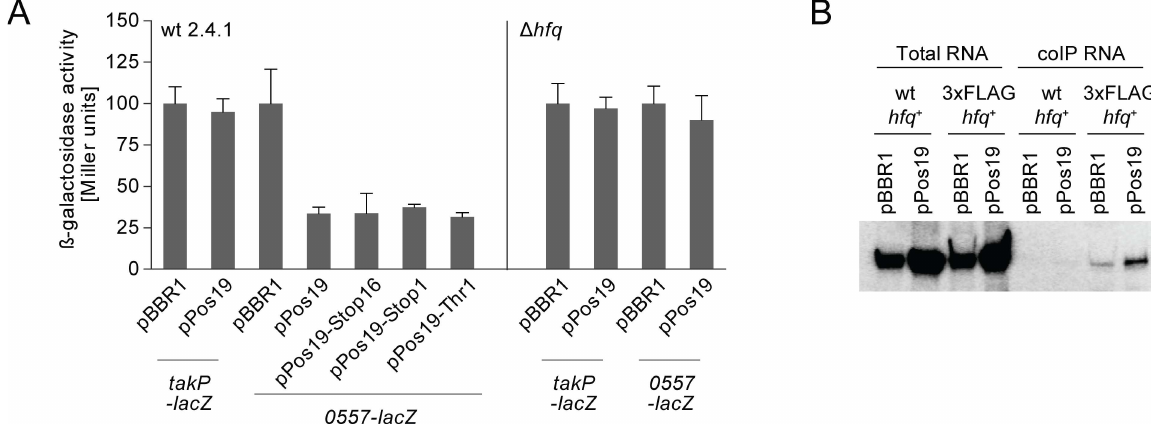
Fig 5. Regulation of RSP_0557 by Pos19 depends on Hfq. (A) Results from in vivo reporter studies. Gene fragments containing the first codons and part of the upstream region were translationally fused to the lacZ gene on plasmid pPHU235. The corresponding reporter plasmids were transferred to control (pBBR1) and over-expression strains of Pos19 (pPos19) in wild-type (wt 2.4.1) and hfq deletion mutant ( Δ hfq ) backgrounds. Cultures were stressed with 1 O 2 for 60 min and samples subjectedto β -galactosidase assays. Bars indicate the relative β -galactosidase activity as calculatedfrom Miller units (with the pBBR1 control set to 100% for each construct). Results represent the mean from three independent experiments with technical duplicates and error bars reflect the standard deviation. (B) Northern blot results from Hfq coIP experiments. Control plasmid pBBR1 and over-expression plasmid pPos19 were transferred to strains either expressing wild-type Hfq (wt hfq + ) or 3xFLAG-tagged Hfq (3xFLAG hfq + ). Resulting strains were exposed to 1 O 2 for 30 min at an OD 660 of 0.4. Cell extracts were appliedto total RNA (input) and coIP RNA (output) extraction. Six μ g of total RNA and 350 ng of coIP RNA were loadedon polyacrylamide gels for detection of Pos19.